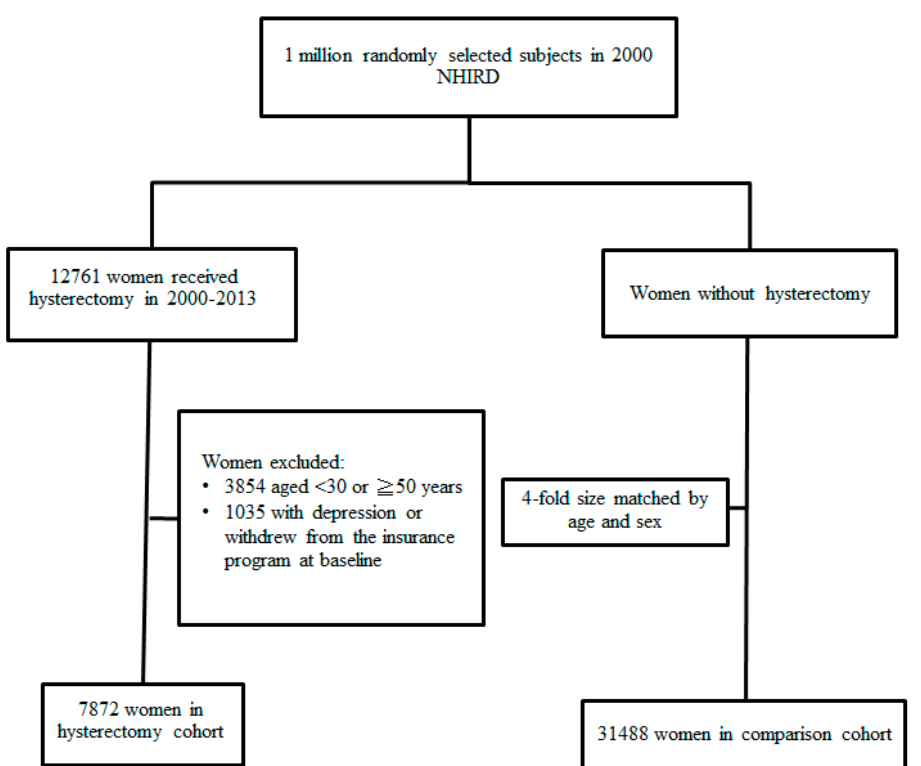
Figure 1. Flow chart of the process for establishing the hysterectomy cohort and controls using the National Health Insurance Research Database.